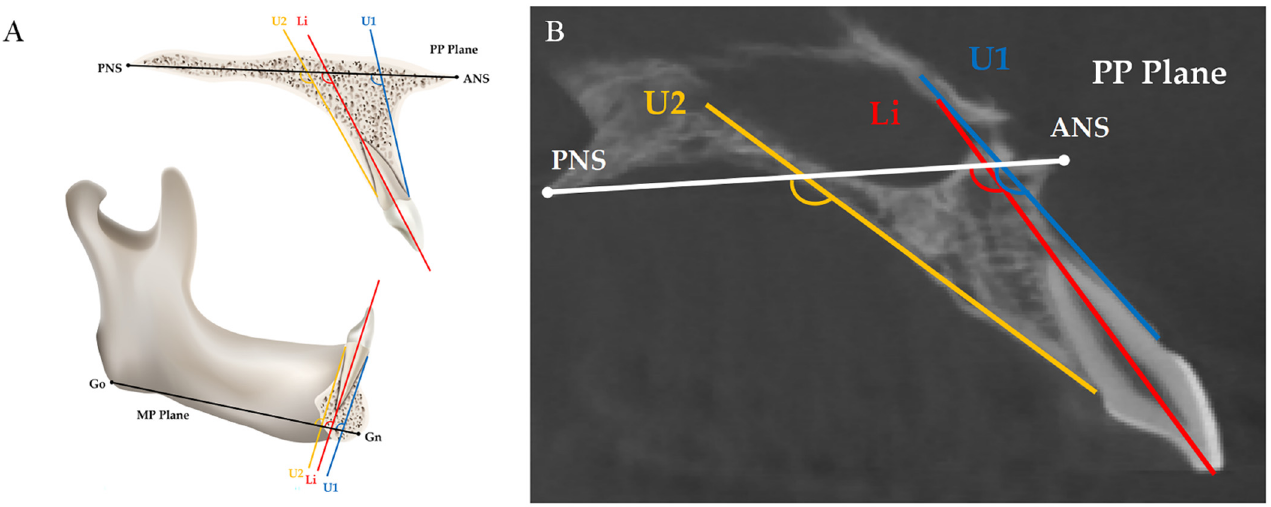
Figure 4. ( A ) Schematic diagrams of the measurement of angular changes in incisors and alveolar ridge. Red line: the long axis of the incisor; blue line: the labial alveolar ridge measurement plane; yellow line: the palatal alveolar ridge measurement plane; ( B ) measurements on actual CBCT images.